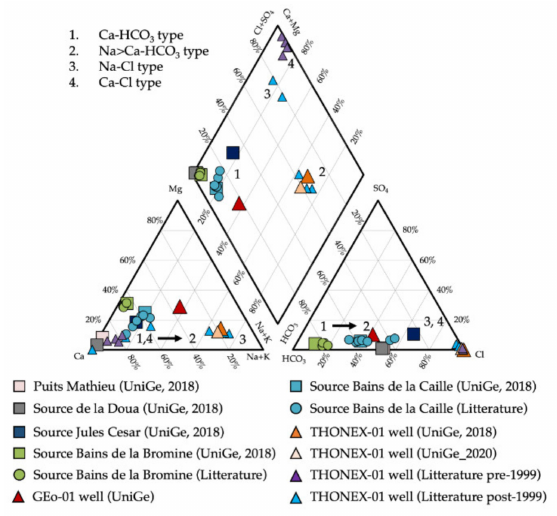
Figure 3. Piper diagram showing the groundwater types in the study area.